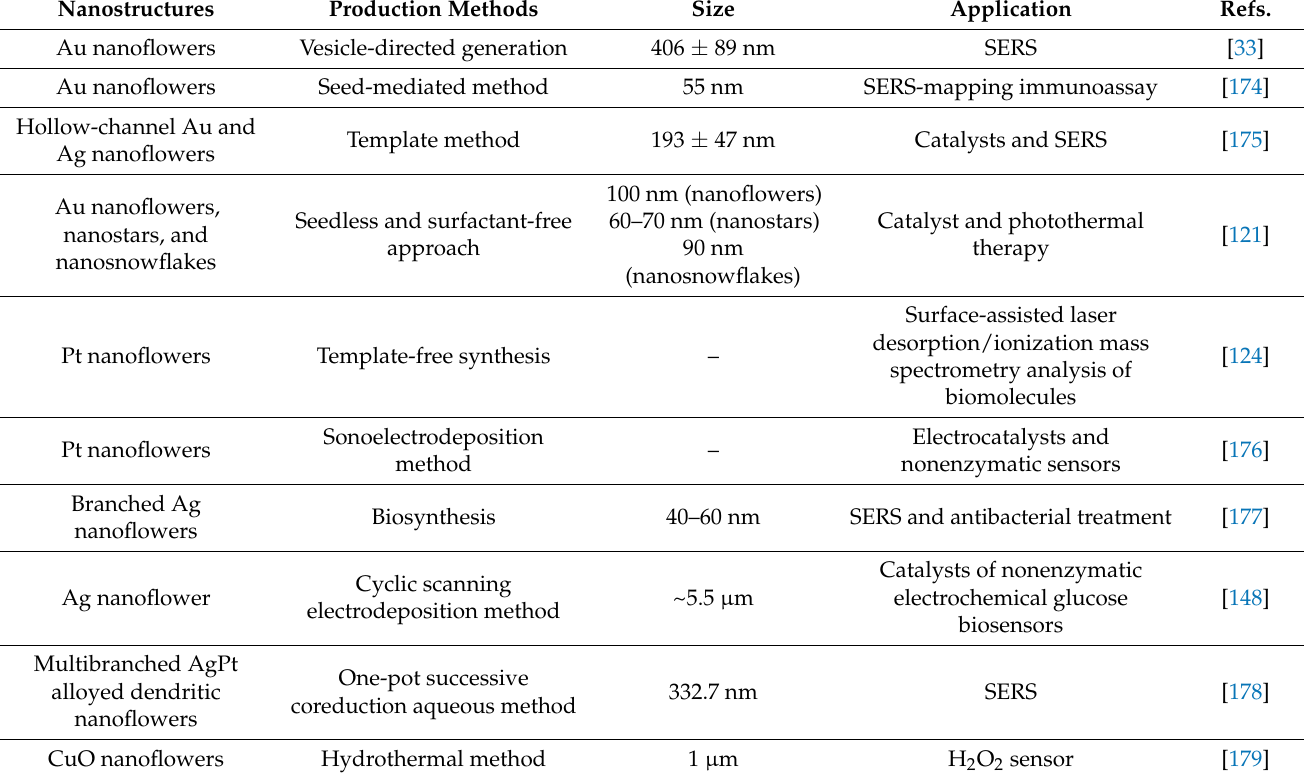
Table 2. Inorganic hierarchical flowerlike nanomaterials and their biomedical